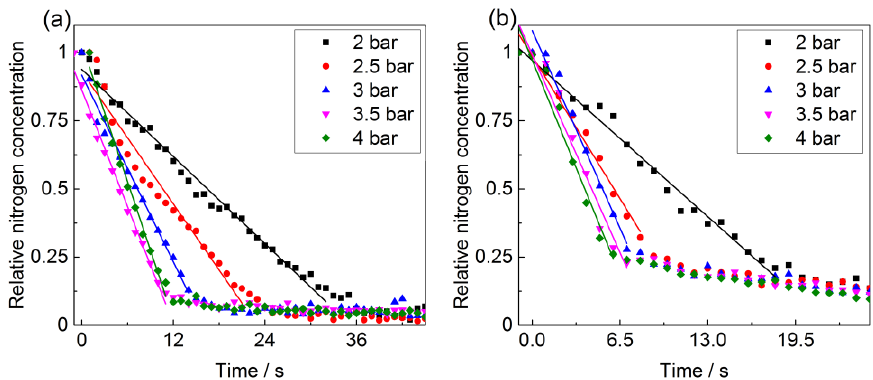
Figure 6. Normalized nitrogen scattering rate during exchange with natural gas from PBG-PCF with lengths of ( a ) 27 cm and ( b ) 15 cm. The purge valve is used to quickly change the gas in the dead volume in front of the fiber. Once it is closed, the measurement starts. Notably, the decrease in scattering rate is now linear during the gas exchange process.